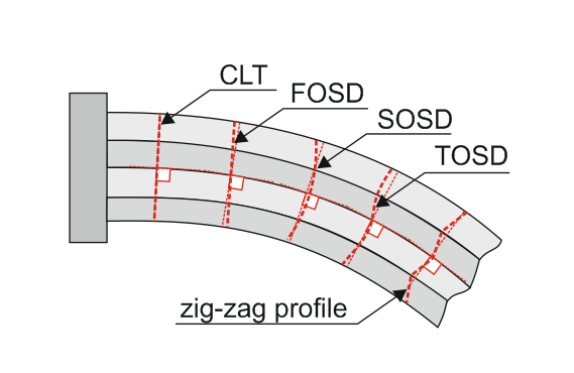
Figure 3. Deformation profiles of a layered panel represented by dif- ferent shear deformation models.